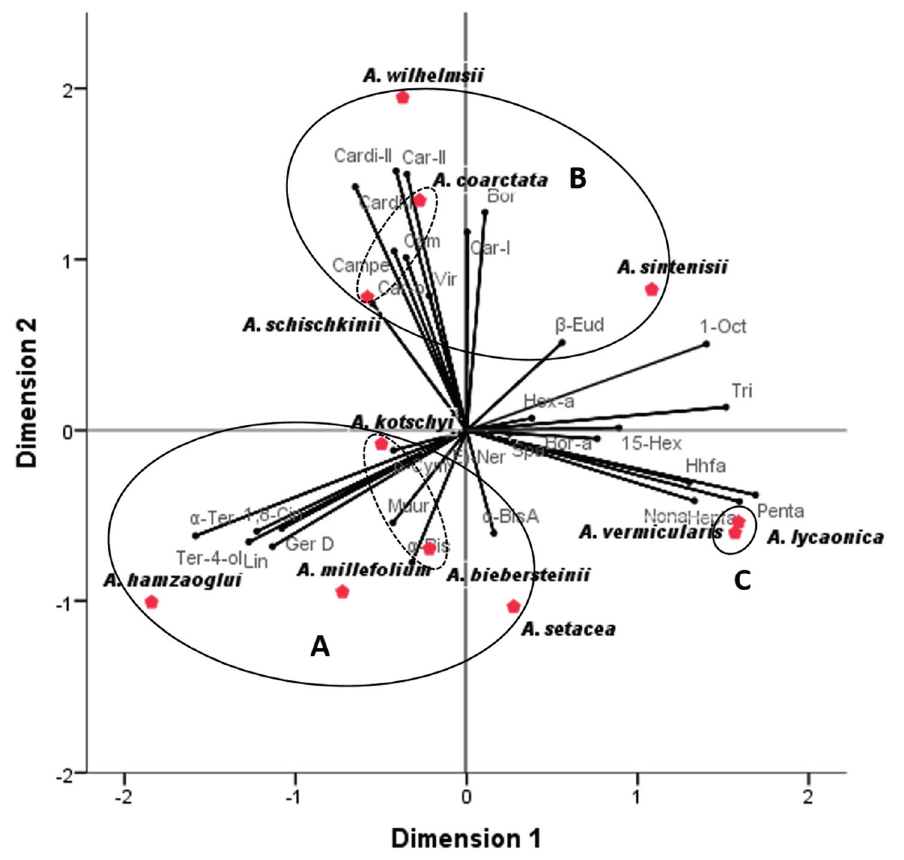
Figure 1. PCA biplot of major volatile compounds of eleven Achillea species according to the clusters ( A – C ) they belong to. Axes refer to scores for the samples and loadings from the volatile constituents represented as vectors from the origin. 1-Oct: 1-Octadecanol;